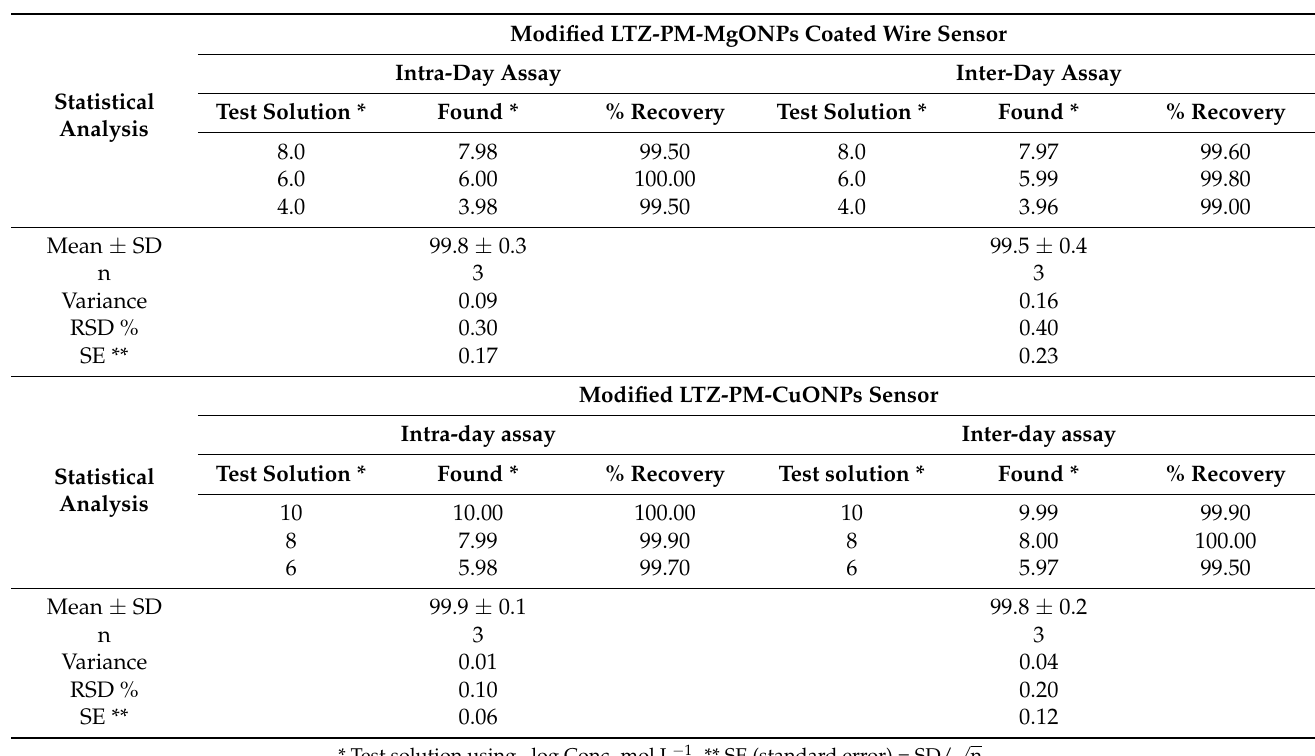
Table 4. Intermediate precision assay of LTZ using modified LTZ-PM-MgONPs and LTZ-PM-CuONPs coated wire sensors.